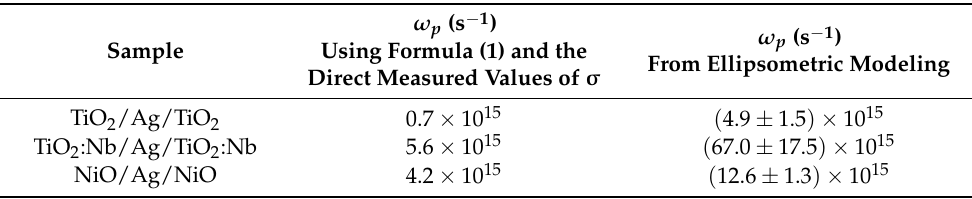
Table 5. A comparison between plasma frequency values obtained from direct electrical measure- ments and from ellipsometric